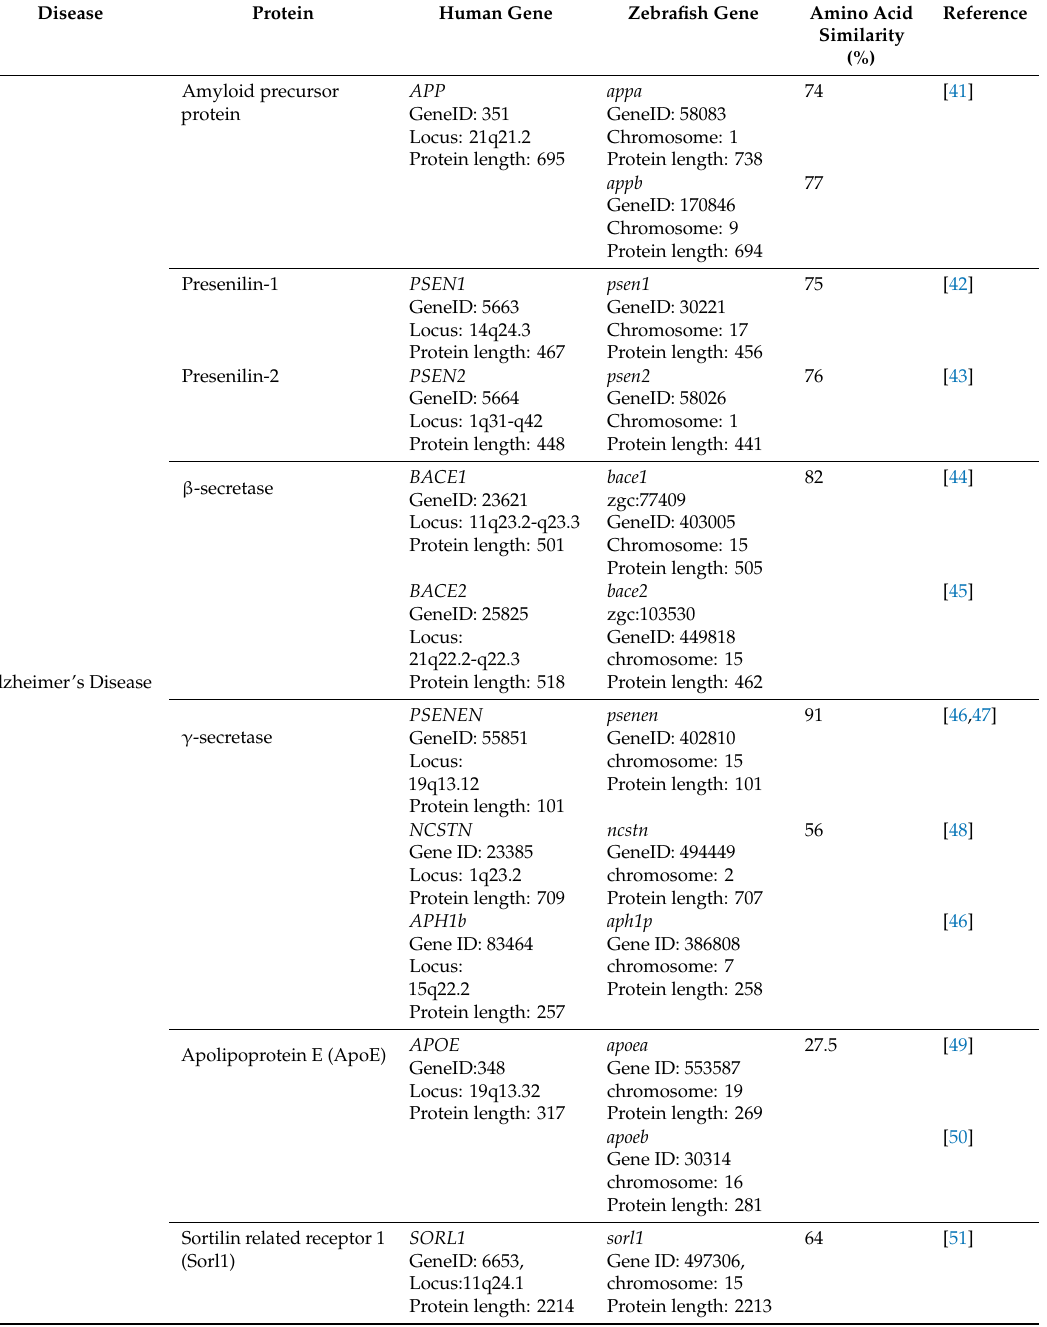
Table 1. Zebrafish orthologs of human genes involved in neurodegenerative disease pathogenesis. Disease Protein Human Gene Zebrafish Gene Amino Acid